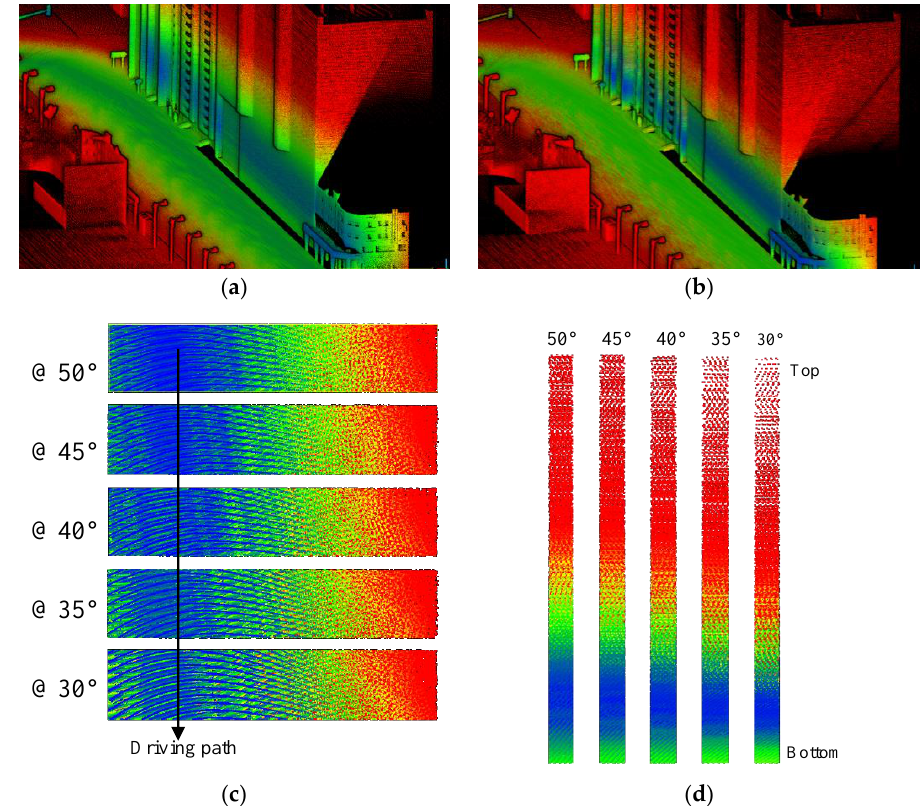
Figure 23. Accuracy labeled point clouds scanned by OS-1-64 (red 𝜎 ≥ 5 cm). ( a ) Accuracy at 50° Lidar tilt angle. ( b ) Accuracy at 30° Lidar tilt angle. ( c ) Accuracy estimated at the ground slice for every tilting angle. ( d ) Accuracy estimated at the façade slice for every tilting angle.